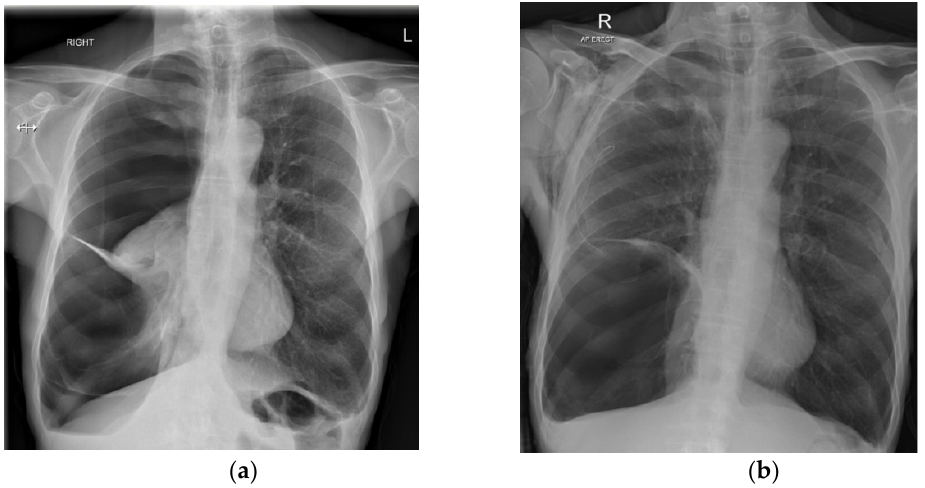
Figure 1. ( a ) A right-sided SSP with evidence of emphysema in the contralateral lung. ( b ) A large bulla evident after drainage and lung reinflation (R, right; L, left).